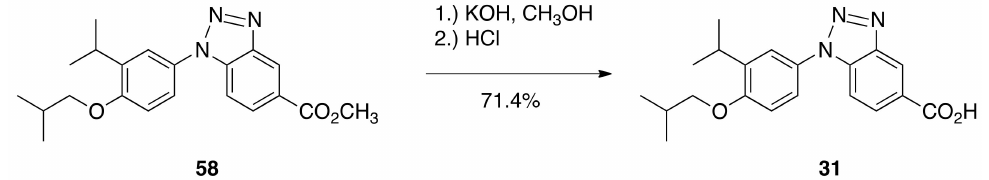
Scheme 6. Synthesis of 31 from 58